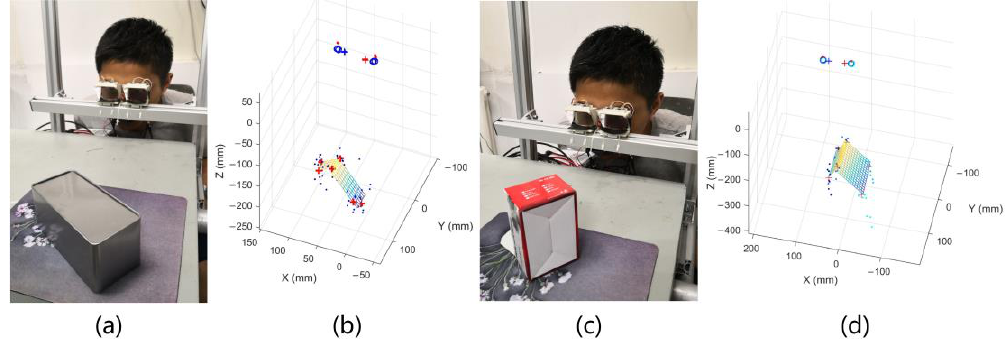
Figure 14. Placing two different boxes in front of the gaze tracking system and allowing the person to look at the six visible corners on the box. ( a ) and ( c ) show the real pictures when a person was looking at the visible corners on the box through the system. ( b ) and ( d ) show the solving result of the corners on the box. The figure shows that this method can output a more accurate response to the stereoscopic perception of human